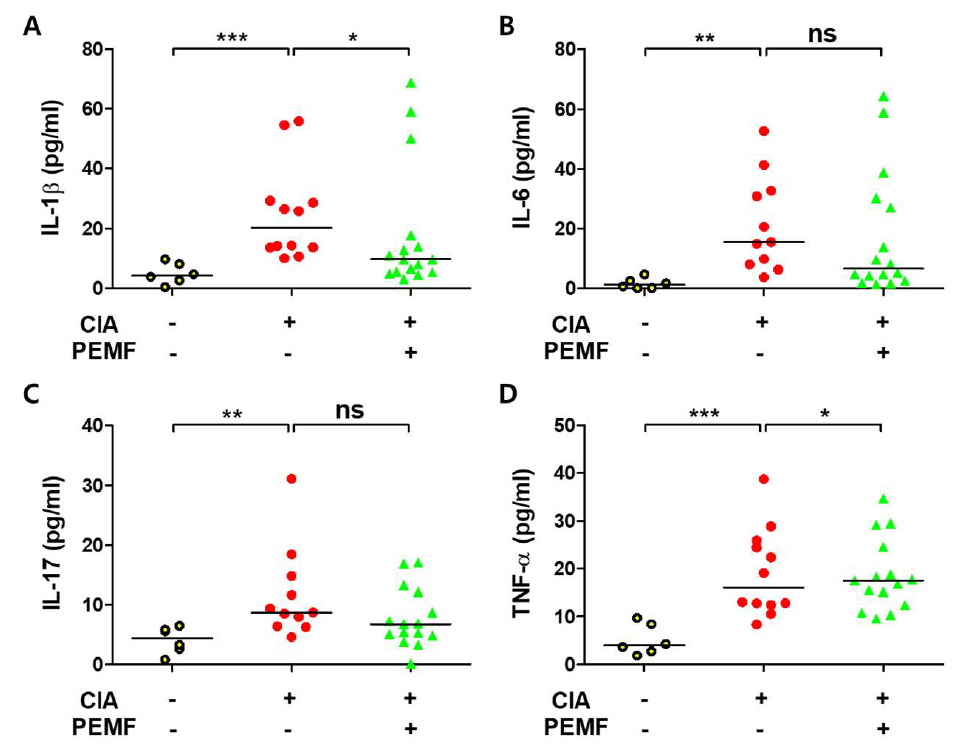
Figure 3. Effects of PEMF (10 Hz) on serum proinflammatory cytokines. ( A ) IL-1 β , ( B ) IL-6, ( C ) IL-17, and ( D ) TNF- α were measured by ELISA in serum obtained on day 60. Grouped quantitative data are presented as medians. Significance was measured using a two-tailed Student’s t -test (* p < 0.05, ** p < 0.01, and *** p < 0.001; ns, not significant). Bars indicate the median. Each dot represents one mouse.